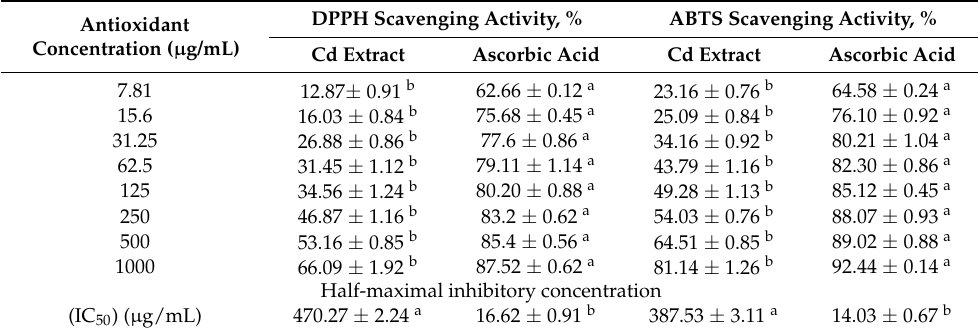
Table 2. Antioxidant activity of the Cleome droserifolia (Forssk.) Del. methanolic extract (Cd extract), as assessed by the 2,2-diphenyl-1-picrylhydrazyl (DPPH) and 2,2 (cid:48) -azino-bis (3-ethylbenzothiazoline- 6-sulfonic acid (ABTS) tests.